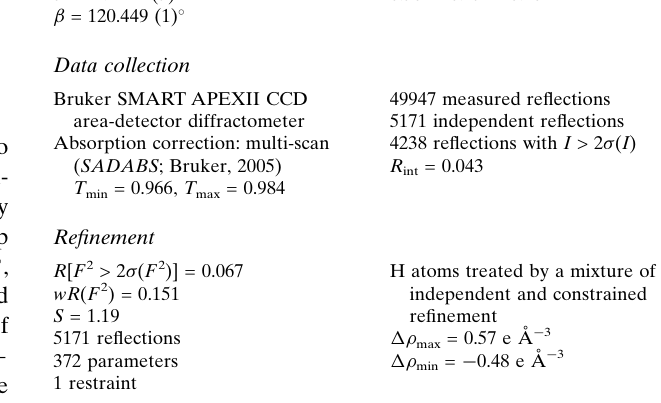
Data collection Bruker SMART APEXII CCD area-detector diffractometer Absorption correction: multi-scan ( SADABS ; Bruker, 2005) T min = 0.966, T max = 0.984